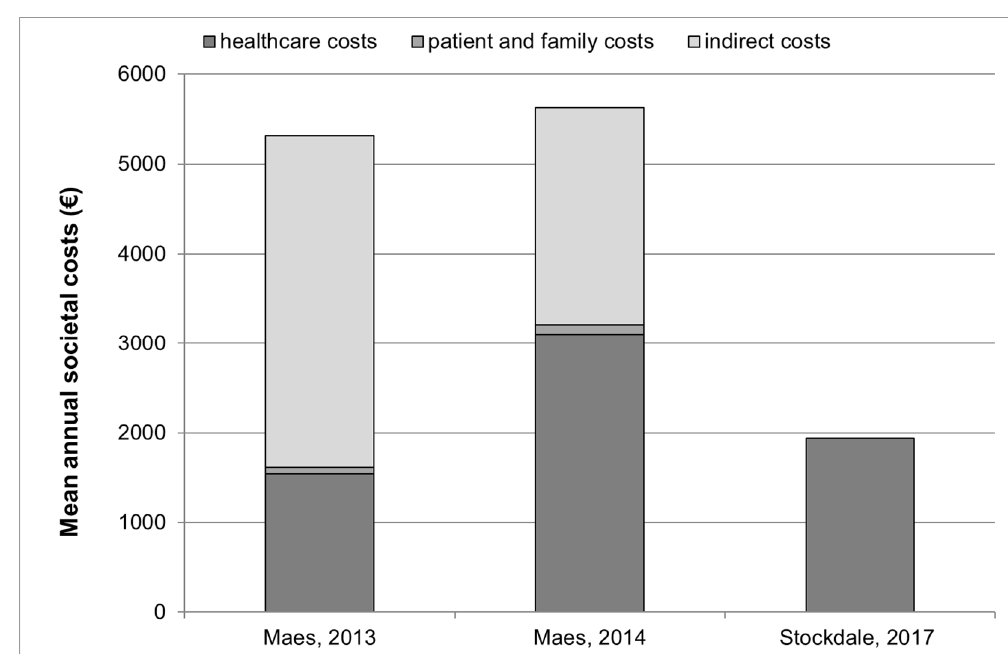
Figure 1. Annual healthcare, patient and family and indirect costs (where available *) for tinnitus management in 3 studies °. * The study by Stockdale et al., 2017 [20] provided information on healthcare costs only. Indirect costs and patient and family costs were not provided in this publication. ° Studies by Goldstein et al., 2015 [22] and Newman and Sandrige, 2012 [23] are not presented in this figure since they did not provide an estimate of overall societal or healthcare costs but only provided estimates for clinical visits, and for sound generators and Neuromonics Tinnitus Treatment.